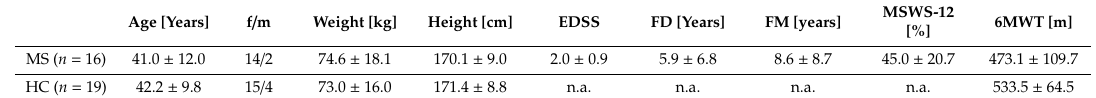
Table 1. Descriptive subject